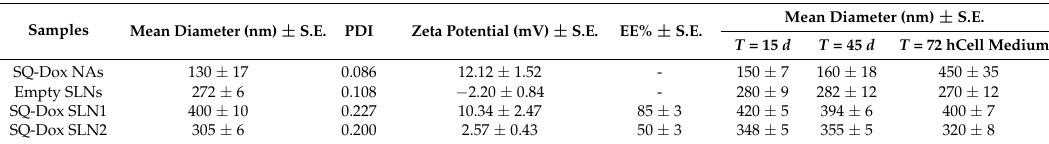
Table 1. Physicochemical characteristics of squalenoyl derivative of doxorubicin (SQ-Dox) nanoassemblies (NAs) and of empty and SQ-Dox-loaded solid lipid nanoparticles (SLNs).